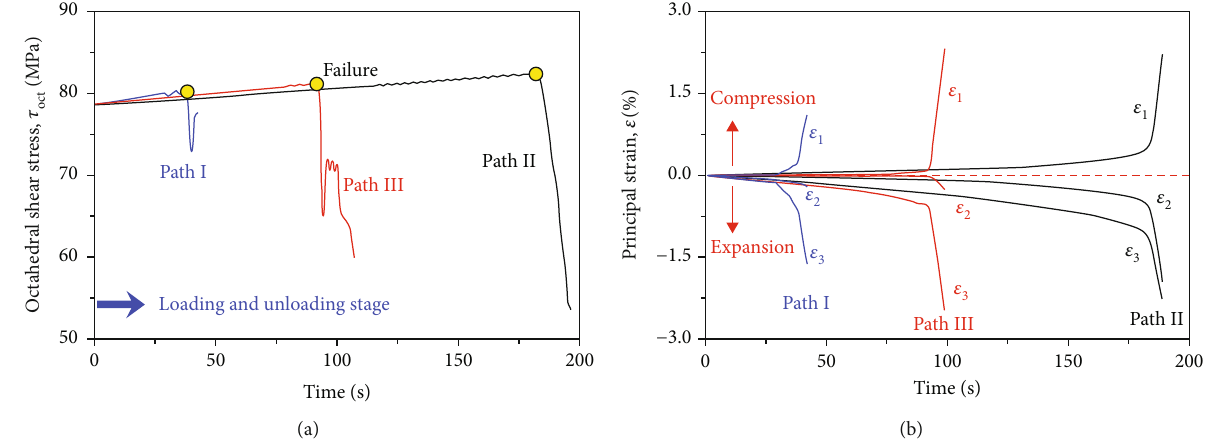
Figure 11: Stress-time curves of two groups of rocks during the unloading stage under path